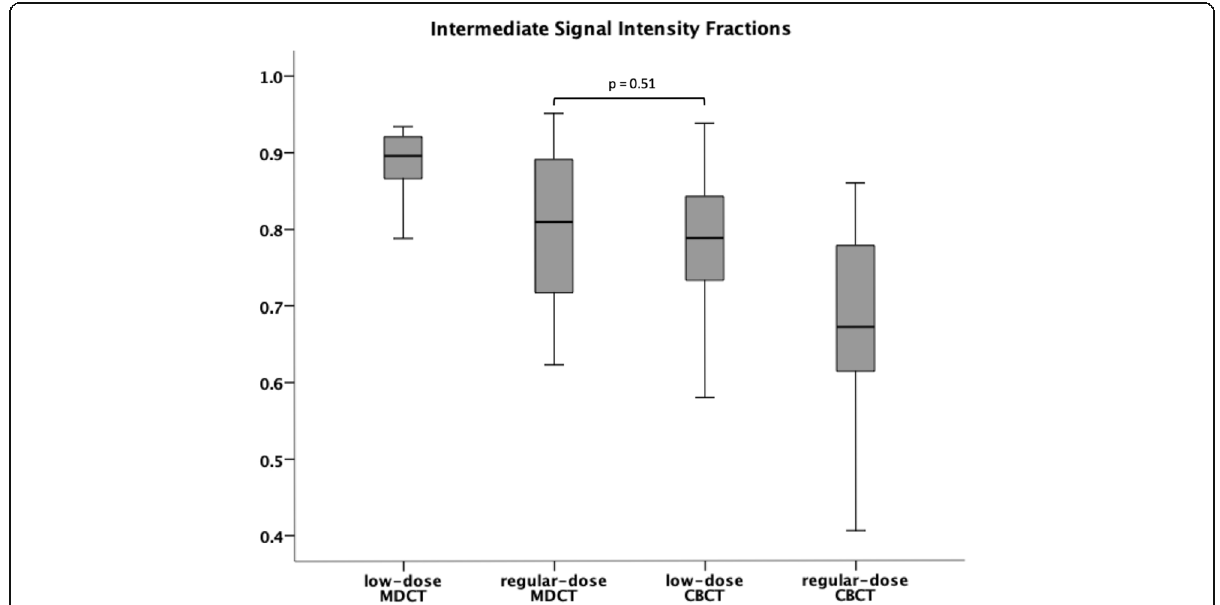
Fig. 4 Boxplots (median and 50% of cases within the boxes) illustrate “ undecided ” pixel fractions within the intermediate range (25 – 75%) of signal intensities for cone-beam computed tomography (CBCT) and multidetector computed tomography (MDCT) scans with dose-equivalent scan protocols. Smaller pixel fractions with intermediate signal intensity indicate superior image quality. Except for the difference between regular-dose MDCT and low-dose CBCT, all differences are statistically significant ( p < 0.001)